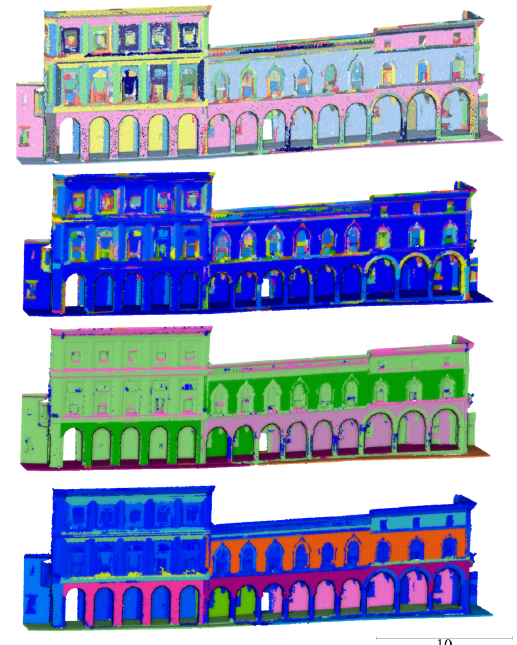
Figure 3. Four levels of clustering features: from top to bottom level 1, 2, 3 and 4.